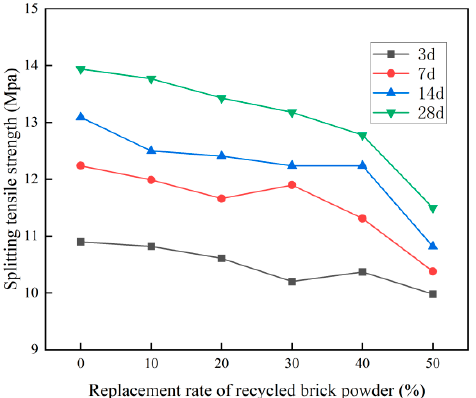
Figure 10. The splitting tensile strength of the recycled micropowder UHPC under different replace- ment rates. Table 6. The effects of the replacement ratio of regenerated micropowder on splitting tensile strength. Replacement Rate